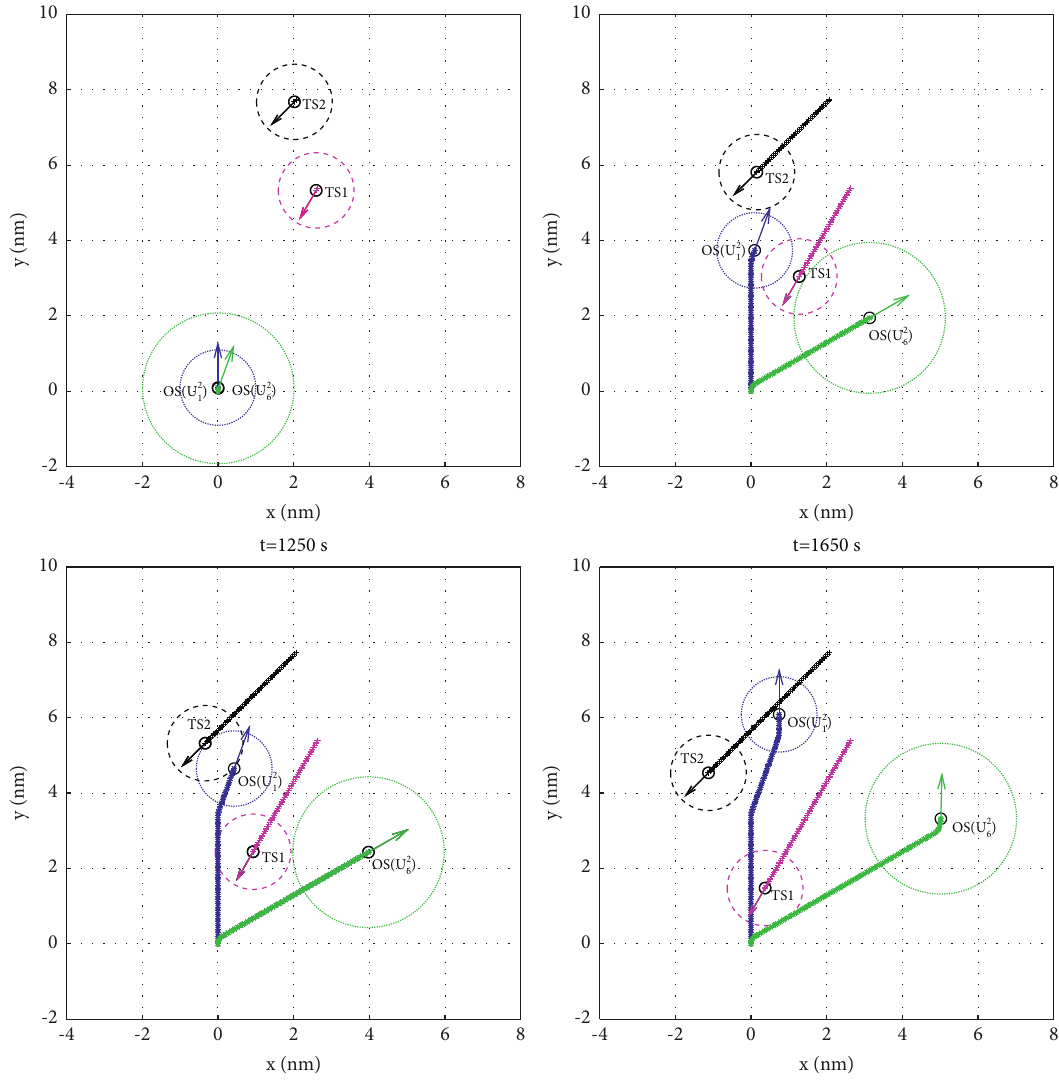
Figure 9: Ship trajectories in Case